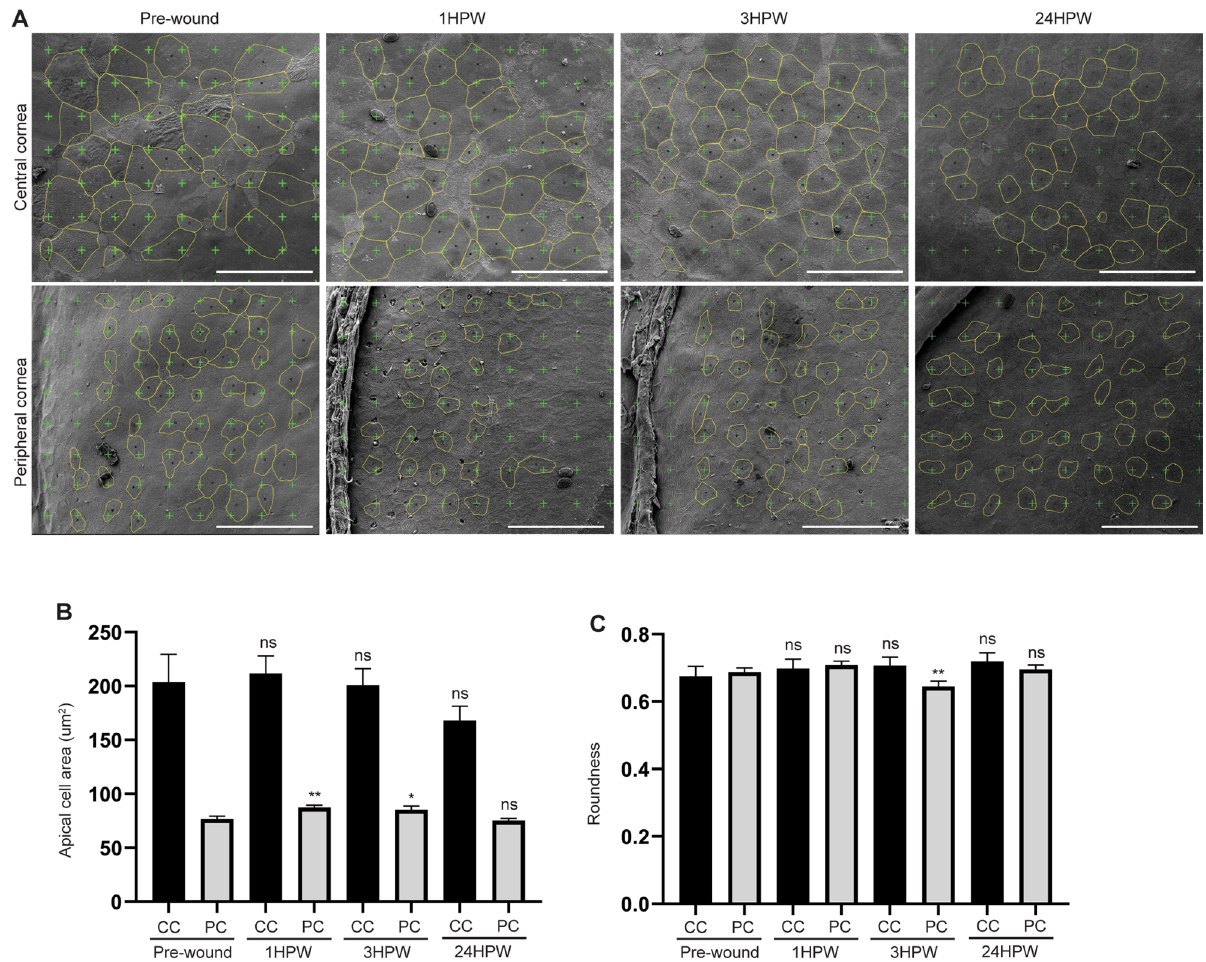
Figure 5. Changes in apical cell area and roundness on contralateral cornea. ( A ) Representative SEM images showing cell shape descriptor analysis before wounding, and 1-, 3-, and 24HPW on central and peripheral regions. ( B ) The quantification of apical cell area shows a slight increase of this parameter at 1 and 3 HPW on the contralateral eye, in peripheral cornea. Cells from 3 eyes were pooled for analysis. ( C ) The quantification of roundness shows a slight decrease of roundness at 3 HPW in peripheral cornea of the contralateral eye. Cells from 3 eyes were pooled for analysis. Data represent mean + 95% confidence interval, P ** < 0.01, P *** < 0.001, P **** < 0.0001, Kruskal–Wallis test followed by Dunn’s test for multiple comparisons. For both B and C, n = 106, 109, 129, and 72 on CC, and 442, 481, 362, and 364 on PC, for pre-wound, 1HPW, 3HPW, and 24HPW, respectively. CC: central cornea, PC: peripheral cornea, HPW: hours post-wound. Scale bars: 50 µm. HPW: hours